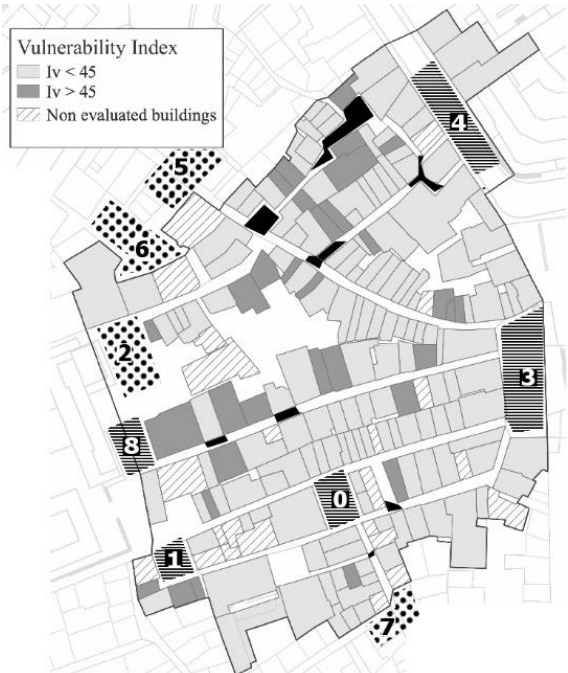
Figure 3. Open spaces usage at the end of the simulation in the SCENARIO A, by evidencing: assembly areas used by more than the 10% of arrived evacuees (dashed areas) and less than the 10% (dotted areas); main areas of spontaneous gathering (full black areas).